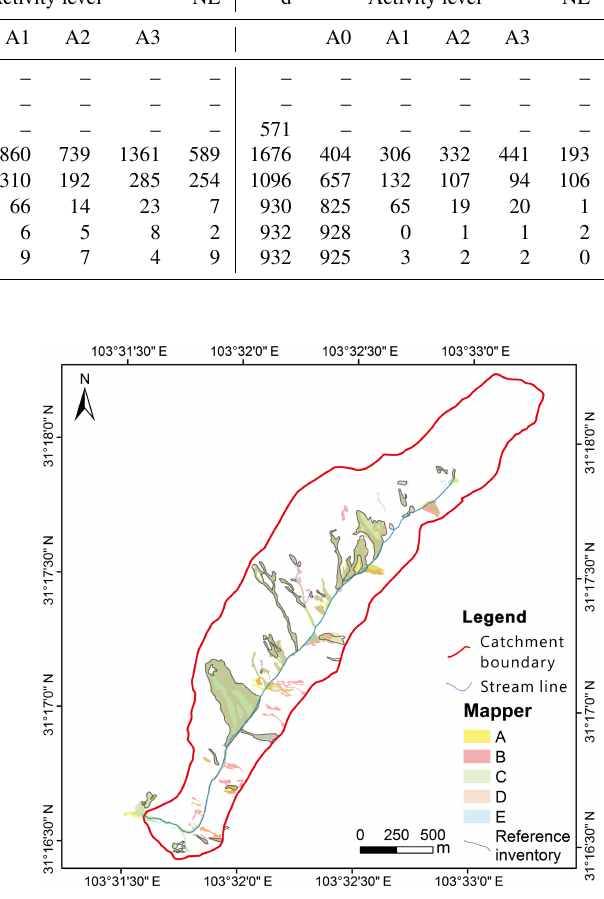
Figure 7. Landslide inventory of a test area (remote-sensing image recorded in 2011): comparison between the reference,